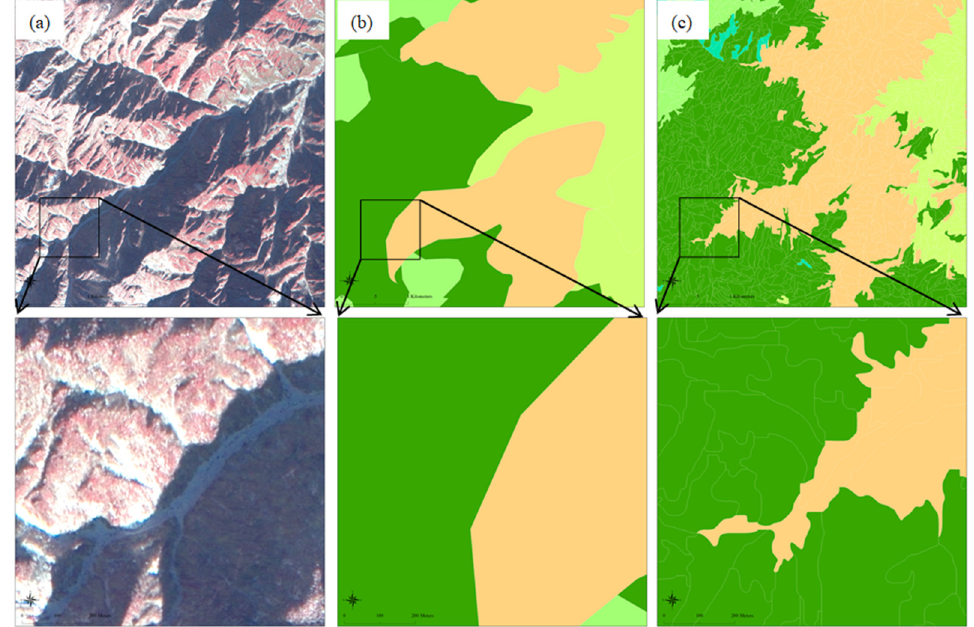
Figure 10. Details of the comparison in subarea A of Figure 9. ( a ) the GF-2 image with a 4/3/2 band combination; ( b ) 1:50,000 vegetation map; ( c ) our mapping result.